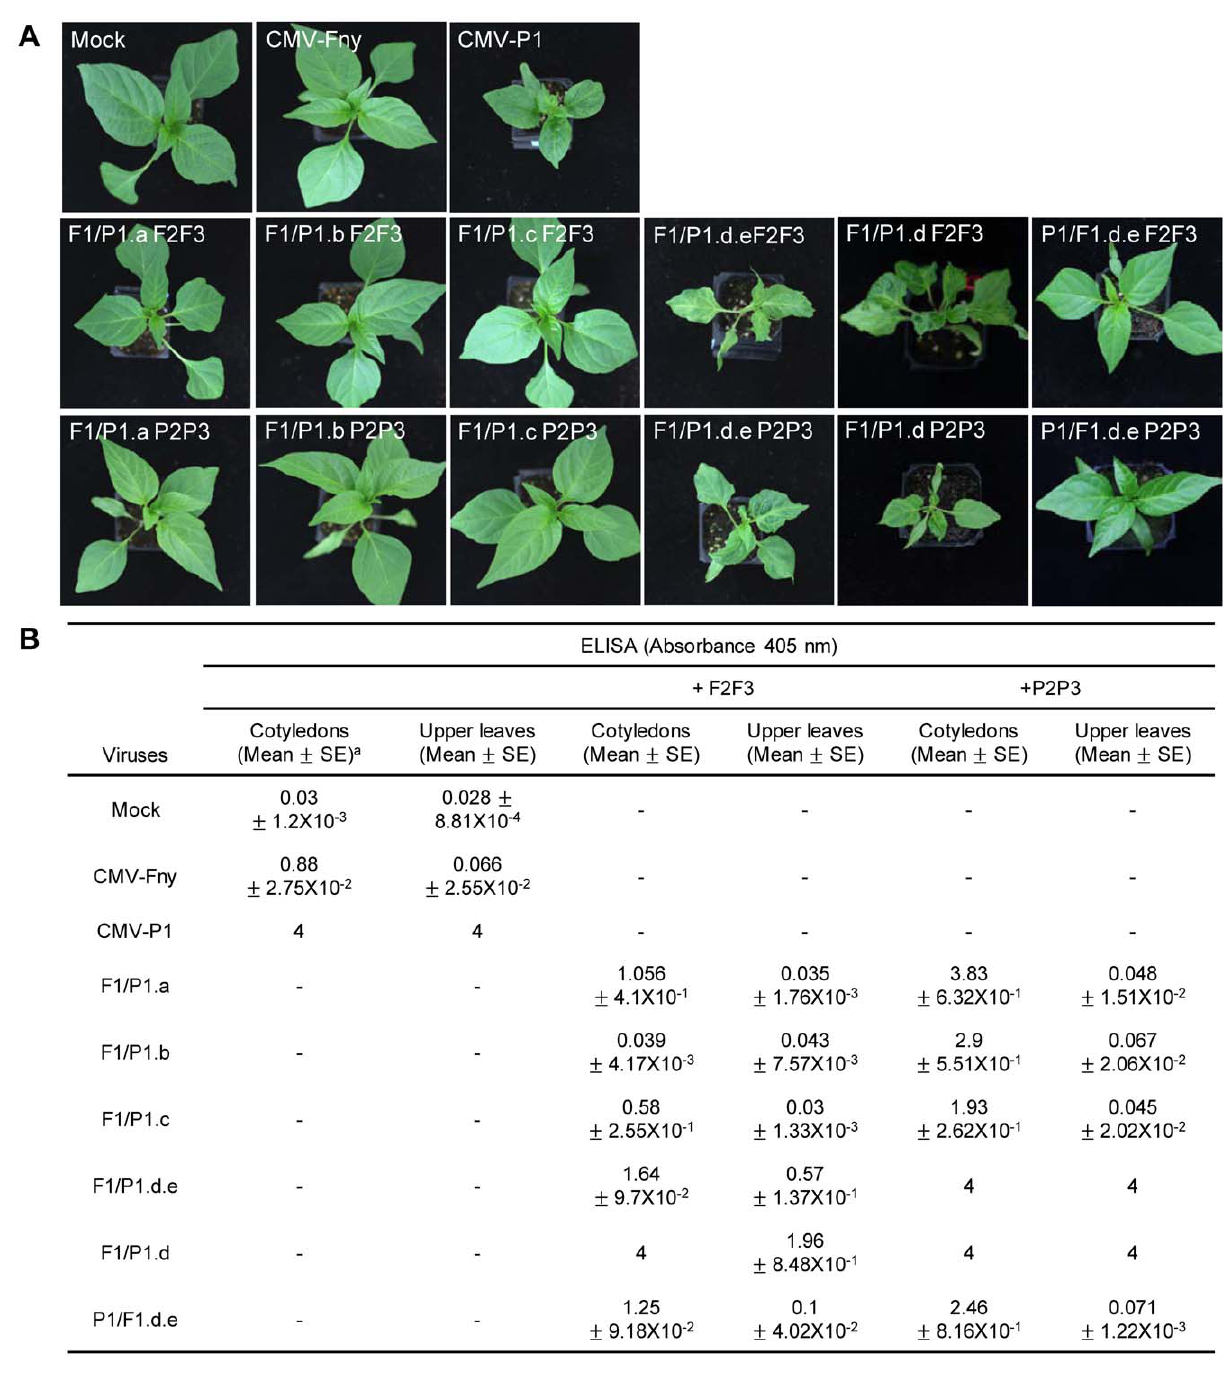
Figure 3. Symptoms in C.annuum ‘Bukang’ inoculated with CMV-Fny, CMV-P1, and CMV RNA1 chimeras. A , Symptoms in C. annuum ‘Bukang’ inoculated with CMV-Fny, CMV-P1, and CMV RNA1 chimeras. Cotyledons were inoculated using sap from infected N. benthamiana . The photographs were taken at 21 days post-inoculation. B , Accumulation of CMV coat protein in inoculated leaves and systemic leaves of peppers was detected using ELISA. Two leaf discs of the inoculated cotyledons and the non-inoculated leaves from each plant were sampled at 21 days post- inoculation. Three independent experiments were each performed in triplicate. a Average of absorbance value and standard errors. doi:10.1371/journal.pone.0043136.g003 er, none of the mutants induced symptoms in the non-inoculated crucial for systemic infection may be the four amino acids at positions 865, 896, 957, and 980. upper leaves. CP of the mutant viruses was detected only in the inoculated leaves of ‘Bukang’ (Figure 4). These results show that the amino acids derived from the CMV-P1 sequence that are